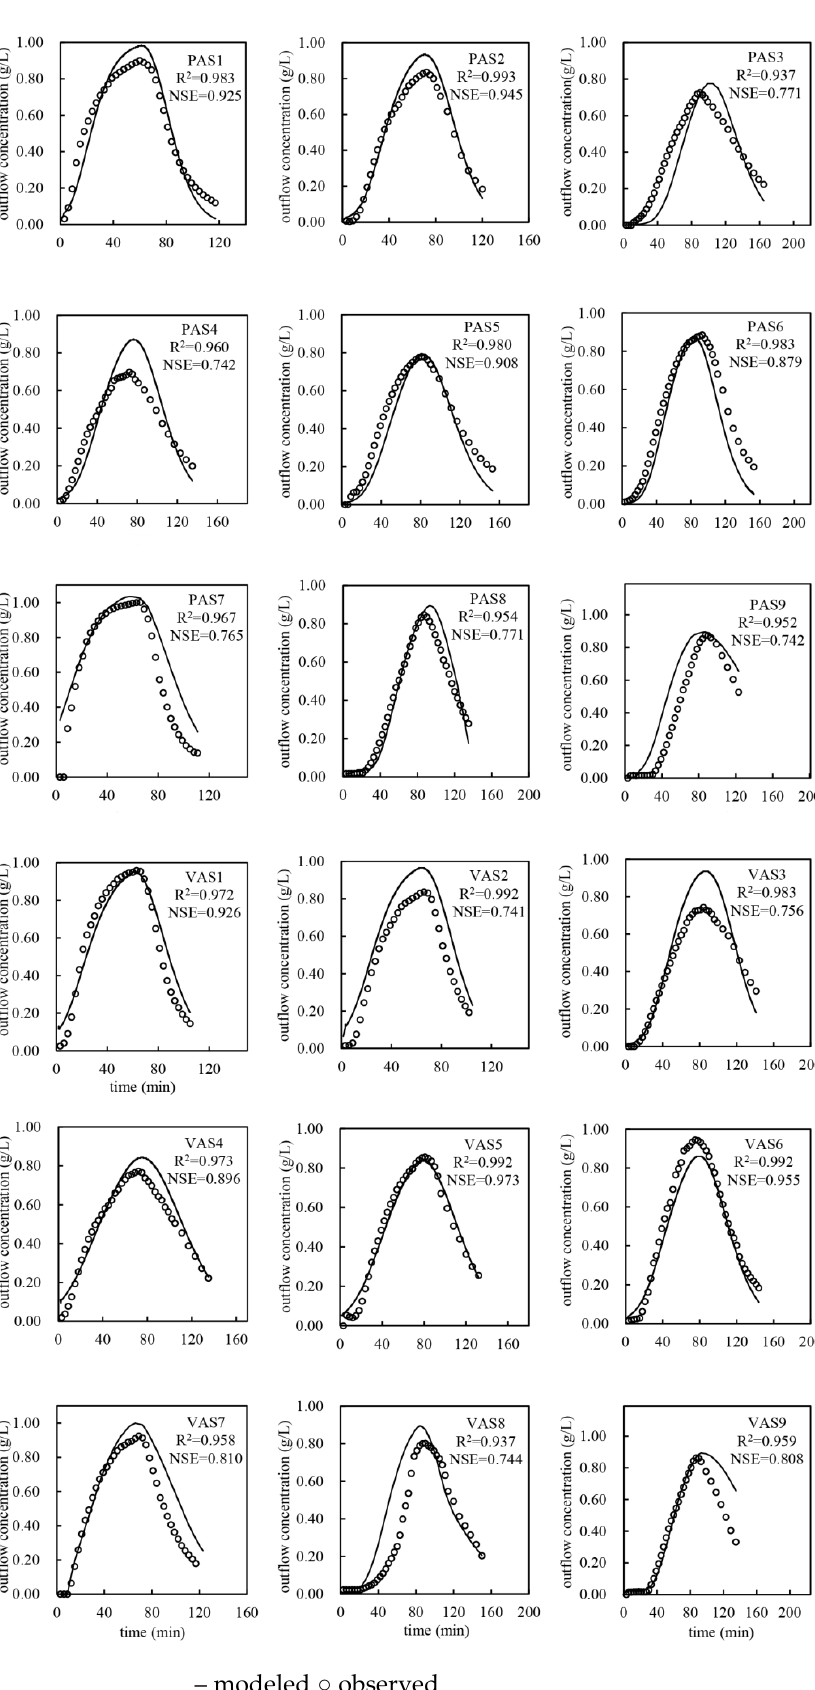
Figure 5. Comparison of predicted and measured outflow concentrations in forward modeling.